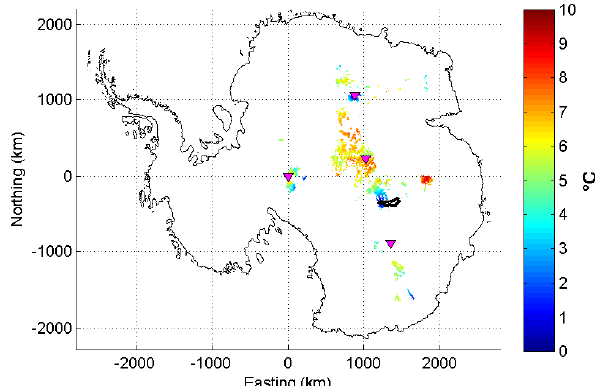
Fig. 7. Potential locations of cold basal conditions in areas with ice thickness H > 2000 m, and horizontal flow speeds < 2 m yr -1 and basal temperatures as calculated with the full model < -5 ◦ C. The colorbar denotes the RMSE ( ◦ C) based on the ensemble calculations.